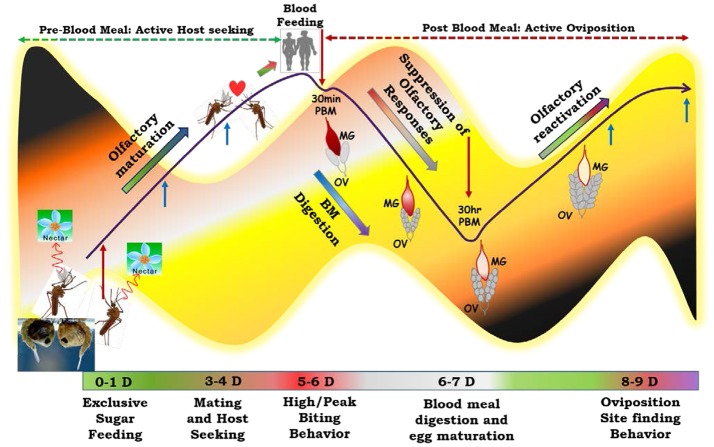
Working Hypothesis to establish functional co-relation of the olfactory system under distinct feeding status: Adult mosquitoes, just after emergence from pupae are exclusive sugar feeders and dependent on nectar sugar to acquire energy for flight activity. Exposure of the adult mosquitoes to the diverse aromatic environment facilitates their learning and maturation of the olfactory system which enables successful mating and host-seeking behavioral activities. But the function of the olfactory system starts to diminish just after blood feeding and become ceased at least for 30 h of post blood meal. Blood feeding initiates lots of physiological changes including blood meal digestion in the midgut and egg maturation in the ovary which consume lots of energy and thus mosquitoes manipulate the energy cost by shutting down the olfactory responses and preferred to take rest at a cool dark place. After 30 h of blood feeding the blood almost digested in the midgut and maturation of egg reached a threshold level which reinforces the mosquito to perform to next level of behavior. Thus, recovery/reactivation of the olfactory responses occurs to find a suitable site for egg laying/oviposition. To capture this molecular snapshot and track the events, we collected olfactory tissues at three different physiological conditions for RNA-Seq analysis (Highlighted as red arrows) and coupled with gene expression study with more elaborated time and physiological state (highlighted with blue arrows). MG, Midgut; OV, Ovary. Mosquitoes each and every life cycle stages are tightly regulated by circadian (dawn & dusk) cycle (Background light dark color code).